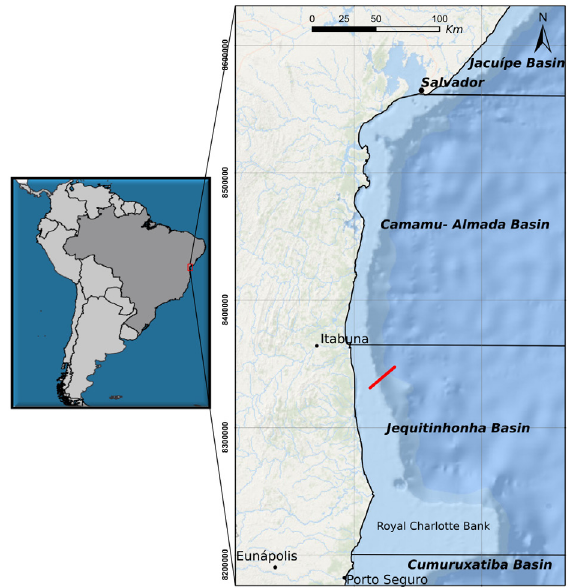
Figure 4. Map indicating the location of the Jequitinhonha Basin. The seismic line used (indicated on the map in red) is located on the slope region, between the continental shelf and the abyssal plain. Source: Agência Nacional do Petróleo, Gás Natural e Biocombustíveis (2018).